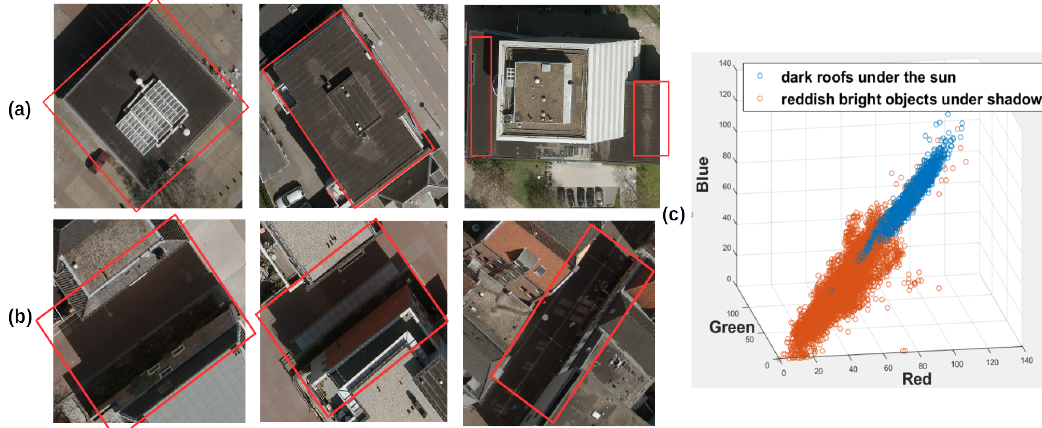
Figure 1. Difficult cases demonstrated in the Amersfoort areas and their distributions shown in the RGB domain. Dark roofs in the sun and reddish objects in the shadow are difficult, and complicated boundaries should be delineated in the RGB